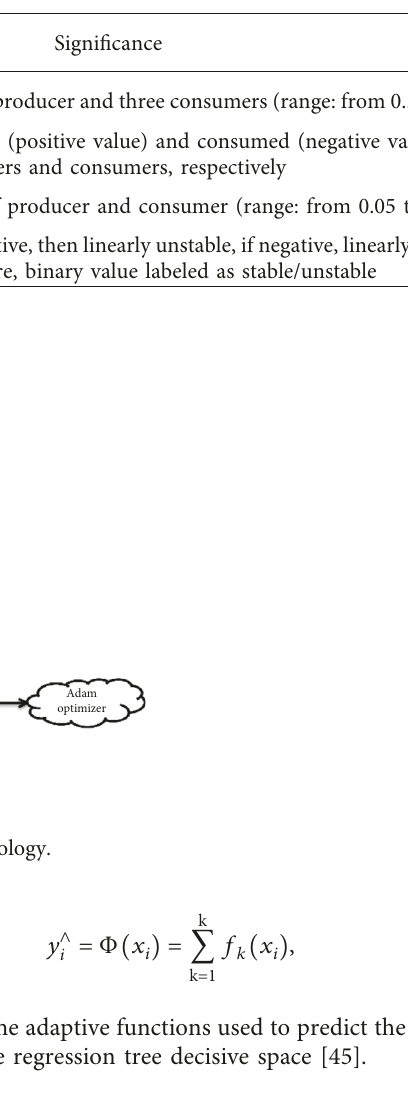
Table 1: Performance parameters for prediction models.